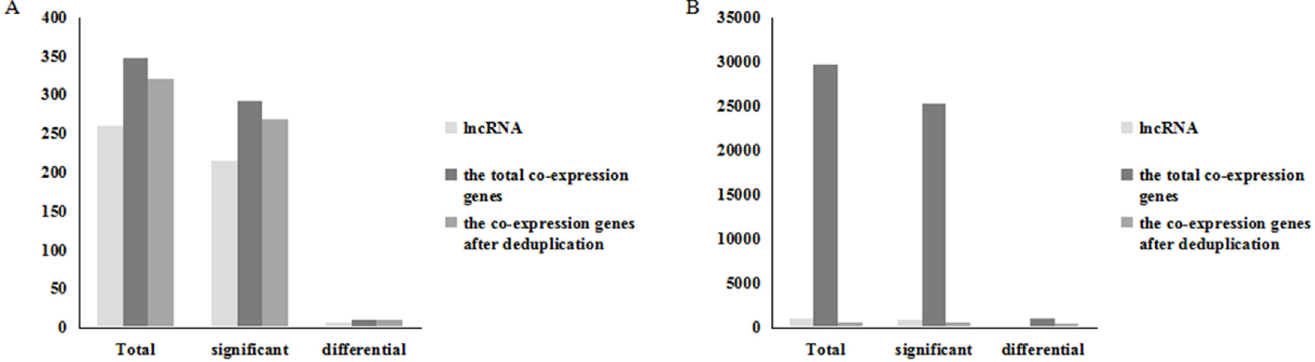
Fig 3. Number of the LncRNA and the co-expression or regulated genes. (A) Numbers of the lncRNAs and the co-expression genes (Trans-acting). (B) Numbers of the lncRNAs and the regulated genes (Cis-acting).